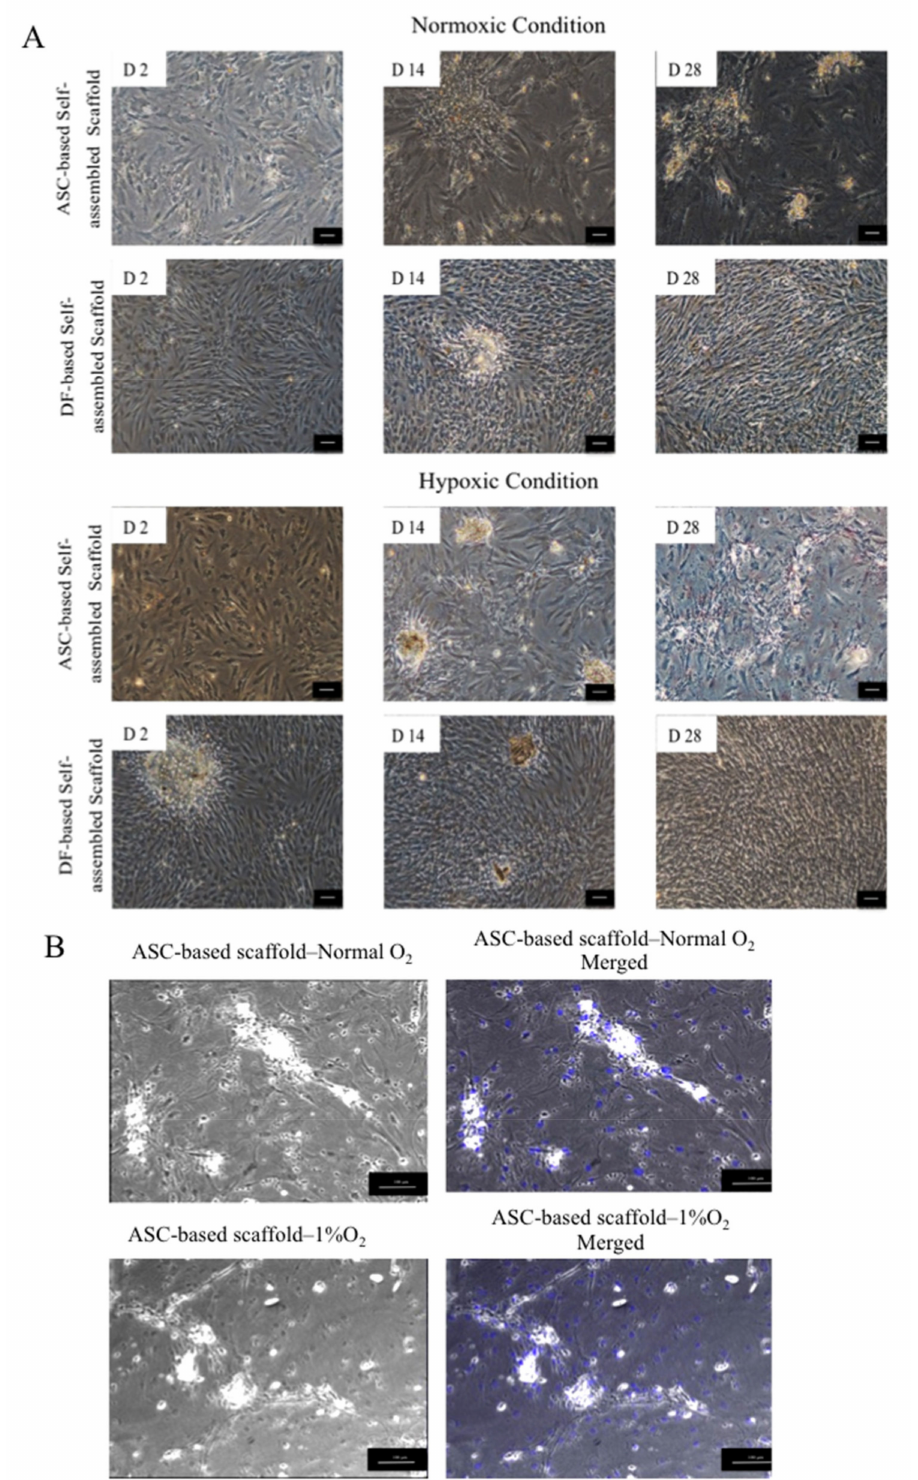
Figure 6. ( A ) Phase contrast imaging of ASC and dermal fibroblast (DF)-based self-assembled scaffolds. ASCs and DFs both remain attached and were proliferating during 28 days of culture period. D 2, D14 and D28, represents Day 2, Day 14 and Day 28, respectively. ( B ) In ASC-based self-assembled scaffold, 4 (cid:48) ,6- diamidino-2-phenylindole (DAPI) was used as nuclear counterstain in blue color. Merged images show the absence of cell nuclei in the formed aggregates. The scale bar represents 100 µ m. Results are from a representative of three independent